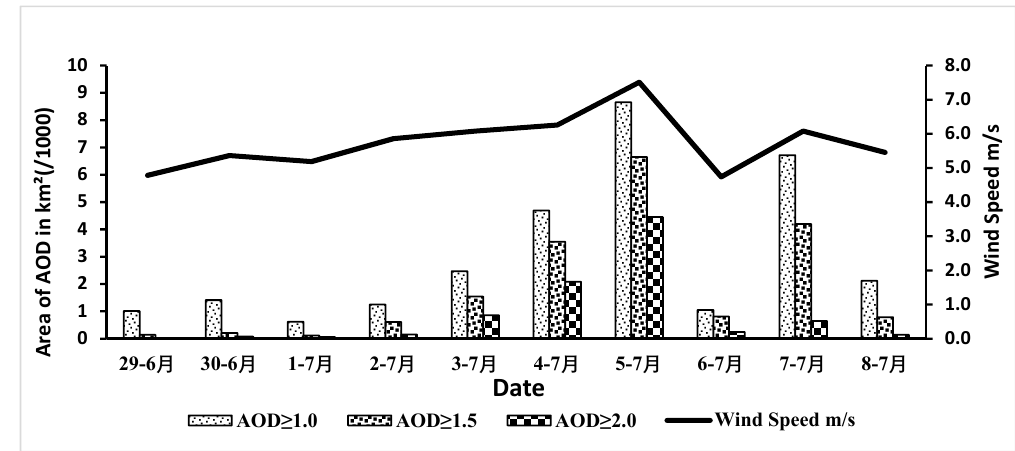
Figure 4. Illustrates the occurrences of AOD for three classes (AOD ≥ 1.0, AOD ≥ 1.5 and AOD ≥ 2.0) with wind speeds through 10 days (June 29–July 8,